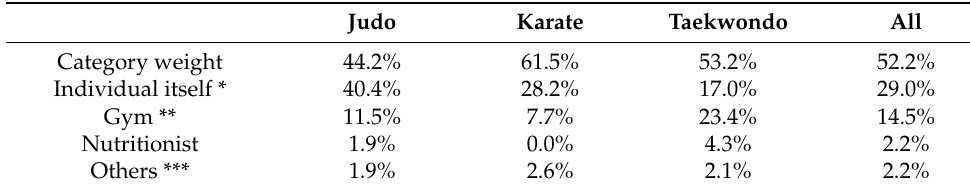
Table 3. Influence of the environment on weight loss.